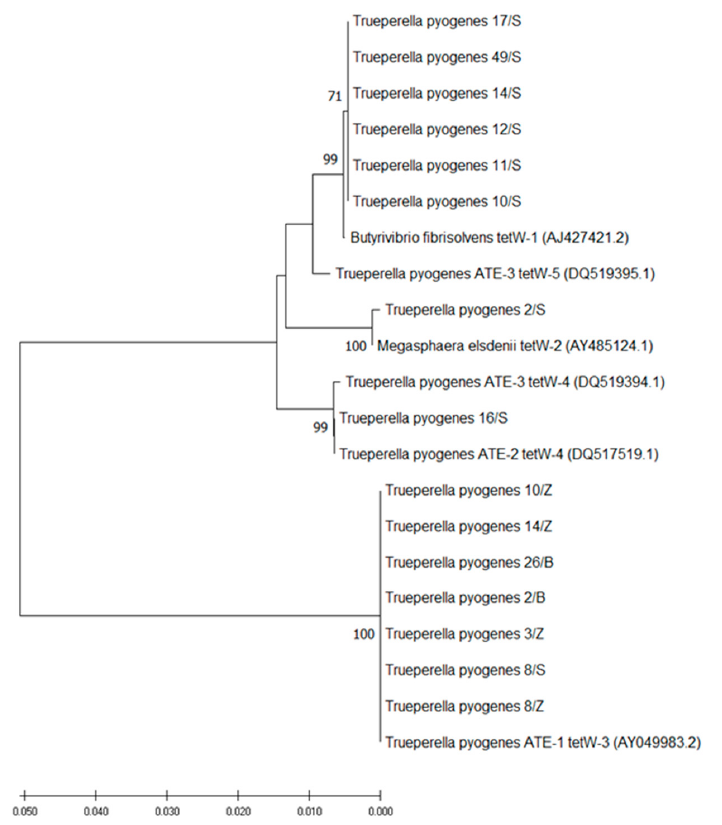
Figure 1. The phylogenetic tree based on a comparison of sequences (933 nucleotides) of the tetW gene of 15 Trueperella pyogenes isolates from this study (2/B, 26/B, 3/Z, 8/Z, 10/Z, 14/Z, 2/S, 8/S, 10/S, 11/S, 12/S, 14/S, 16/S, 17/S, 49/S) and the tetW sequences of selected bacterial species retrieved from the GenBank database (accession numbers in parentheses). The tree was constructed by the neighbor-joining method. Bootstrap values (1000 replicates) of above 70% are shown. The scale bar represents the number of substitutions per site.